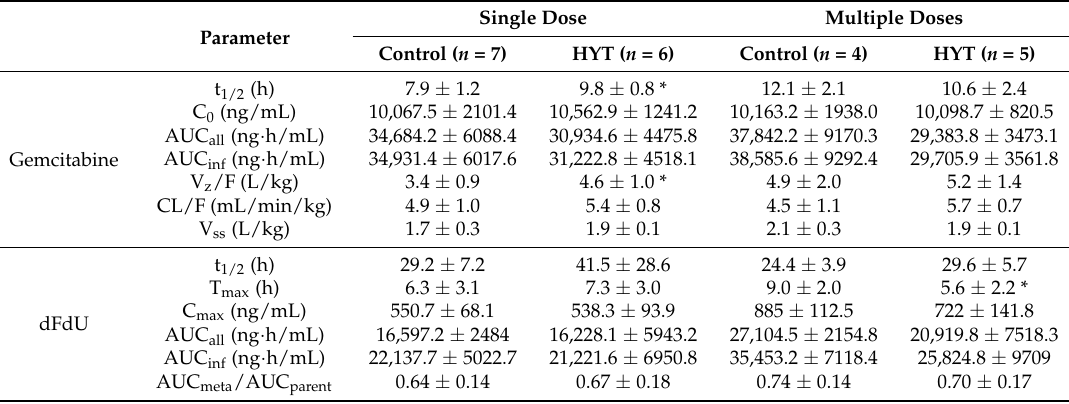
Table 1. Non-compartmental pharmacokinetic parameters of gemcitabine and dFdU following administration of the combination of anticancer agent; gemcitabine (i.v., 10 mg/kg) and erlotinib (p.o., 20 mg/kg) in rats pretreated with 1% CMC-Na (Control) or Hyangsayukgunja-tang (HYT) 1200 mg/kg as a single dose or multiple doses for 14 days.